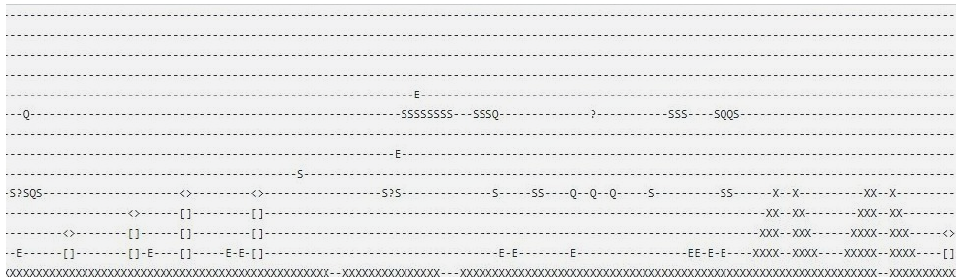
Figure 3. Level representation of Mario Bros in VGLC.